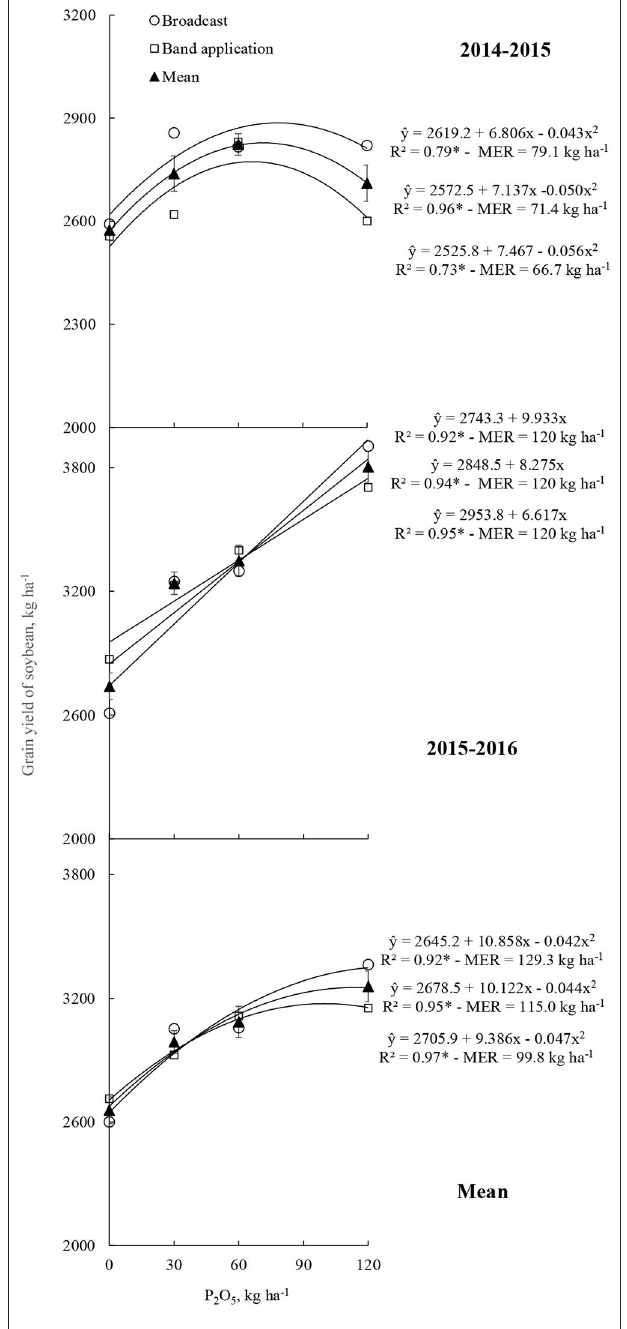
FIGURE 3 | Relationship of the effect of P 2 O 5 rates applied through broadcast or band application in soybean crop, and soybean grain yield in two growing season. MER, maximum estimated rate. *Significant ( F -test, p ≤ 0.05). Londrina, Paraná State,